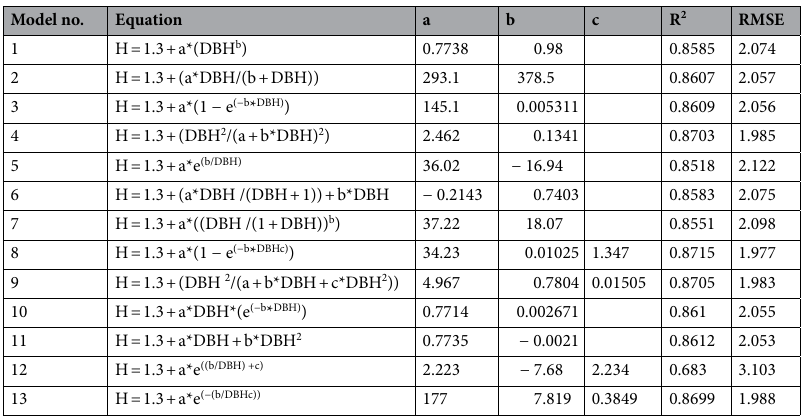
Table 2. Coefficient and fit statistics of different DBH-height equations.